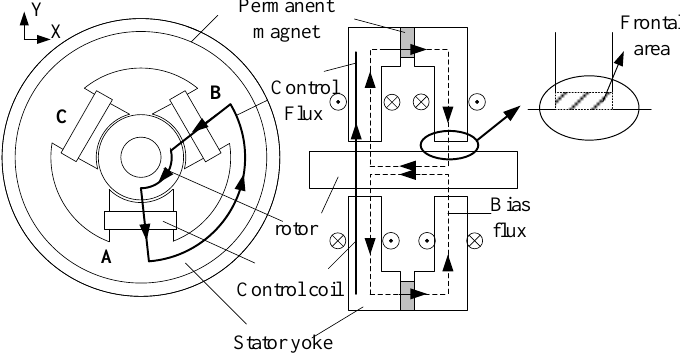
Figure 1. Configuration and flux path of the three-pole radial HMB.